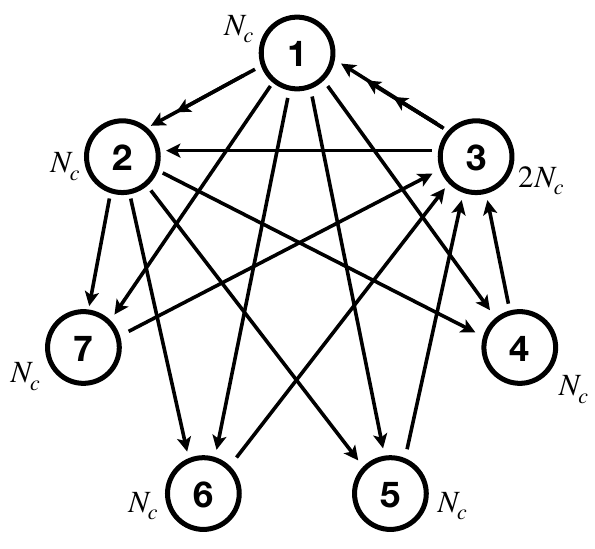
Figure 3 . Quiver for cone over dP 4